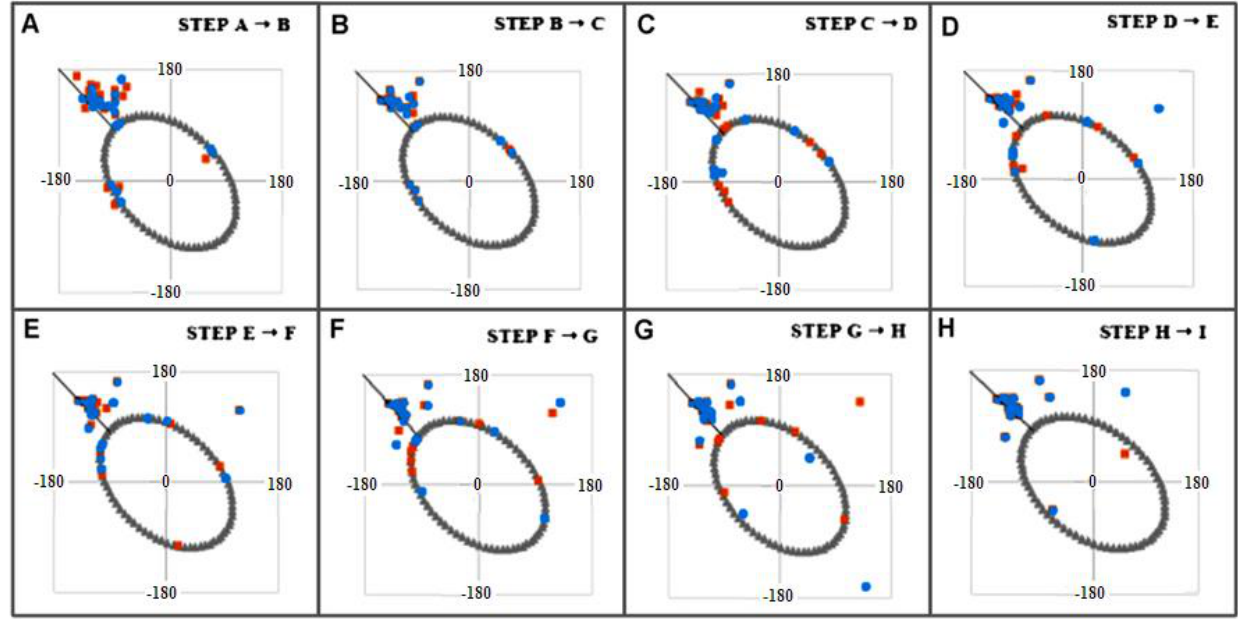
Figure 12. Step-wise changes in Phi and Psi angles following the procedure described above in the text. The red dots represent the conformation of the starting structure—the post-transformation one.